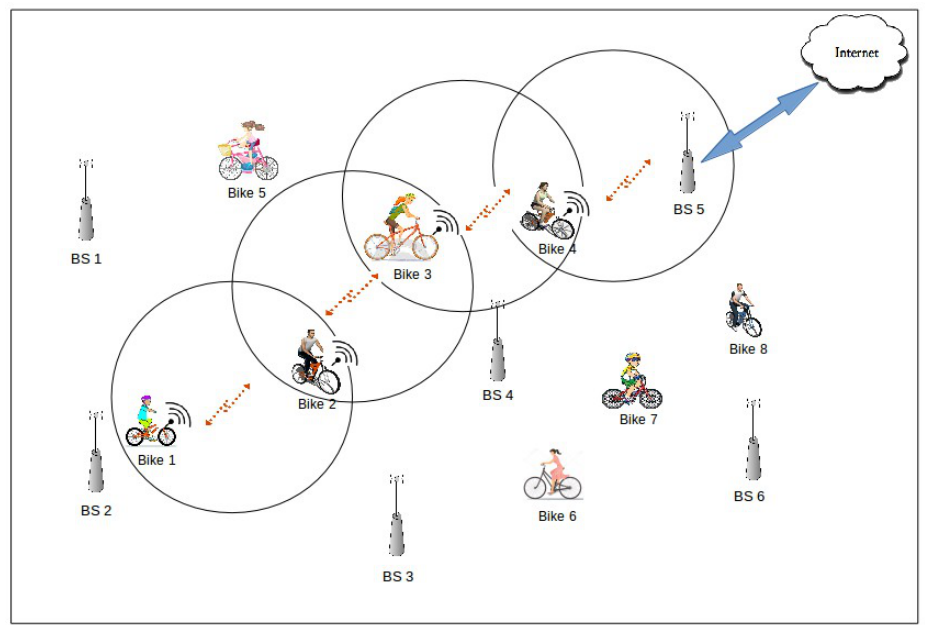
Figure 1. Illustration of our smart bike sharing